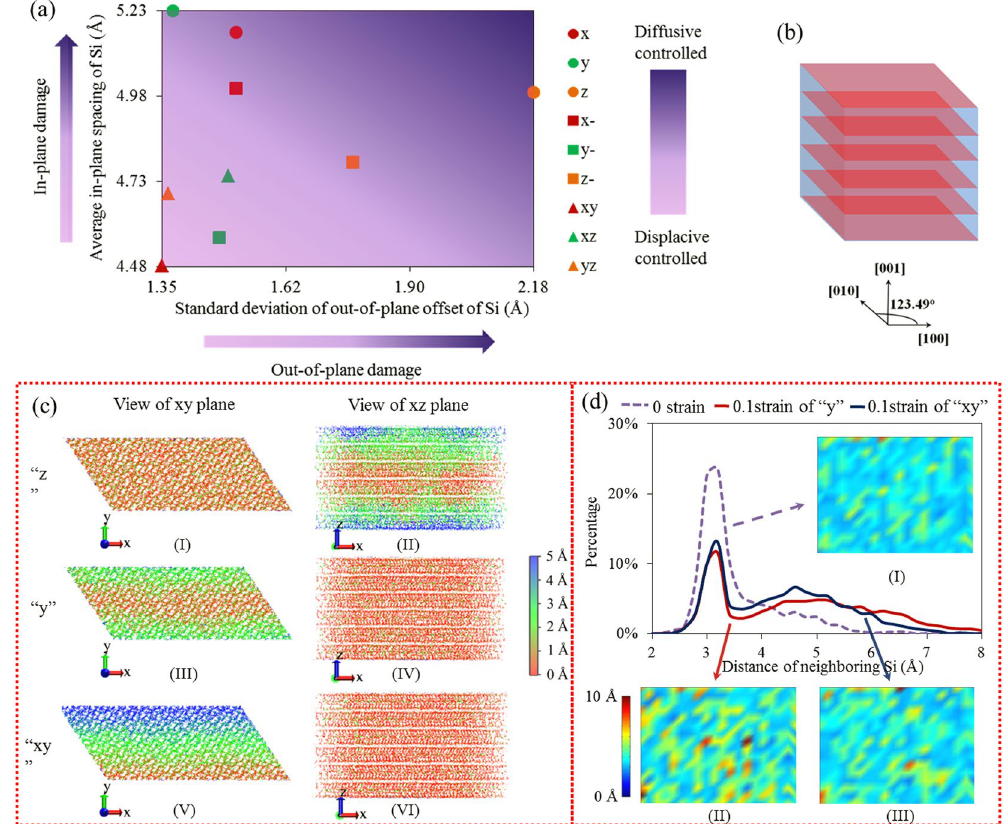
Figure 3. ( a ) Deformation Mechanism Map showing the deformation mechanism corresponding to different global deformation types. The in-plane and out-of-plane damage indexes are calculated when the strain reaches 0.1. ( b ) Schematic diagram of layers stacking along z axis in tobermorite. ( c ) Displacement Map: (I) xy plane view of tension along z axis, (II) xz plane view of tension along z axis, (III) xy plane view of tension along y axis, (IV) xz plane view of tension along y axis, (V) xy plane view of shear in xy plane, (VI) xz plane view of shear in xy plane. ( d ) Distribution of Distance between neighboring Silicon atoms: (I) Distance Map for neighbor Silicon atoms at strain of 0, (II) Distance Map for neighbor Silicon atoms with tension along y axis at strain of 0.1, (III) Distance Map for neighbor Silicon atoms with shear in xy plane at strain of